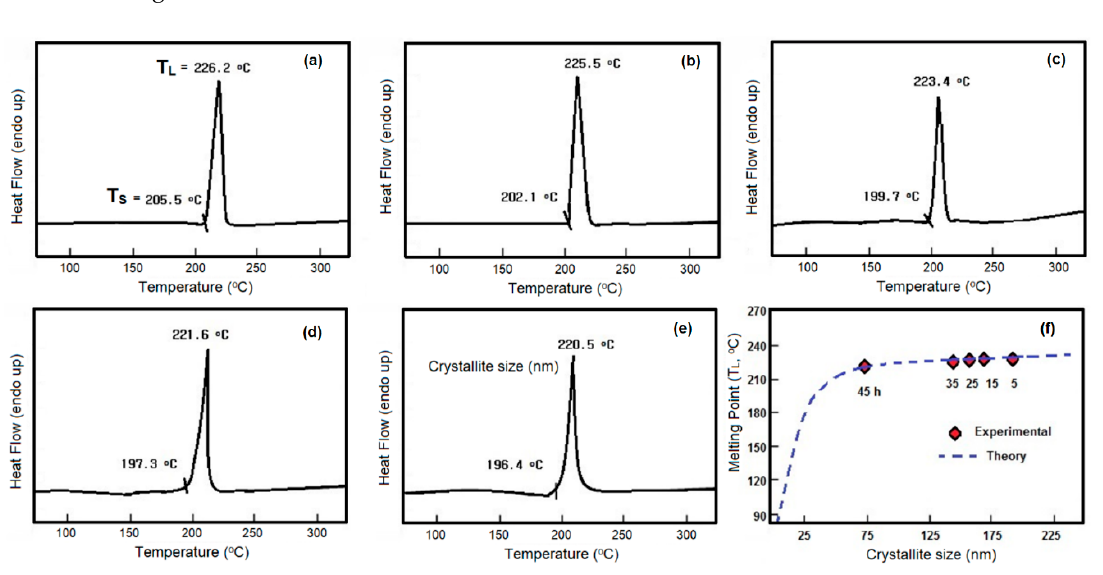
Figure 4. The differential scanning calorimetry (DSC) curve of the Sn-0.7Cu alloy after HEBM for different milling times. ( a ) 5 h, ( b ) 15 h, ( c ) 25 h, ( d ) 35 h, ( e ) 45 h, and ( f ) liquidus of the Sn-0.7Cu alloy as a function of crystallite size.